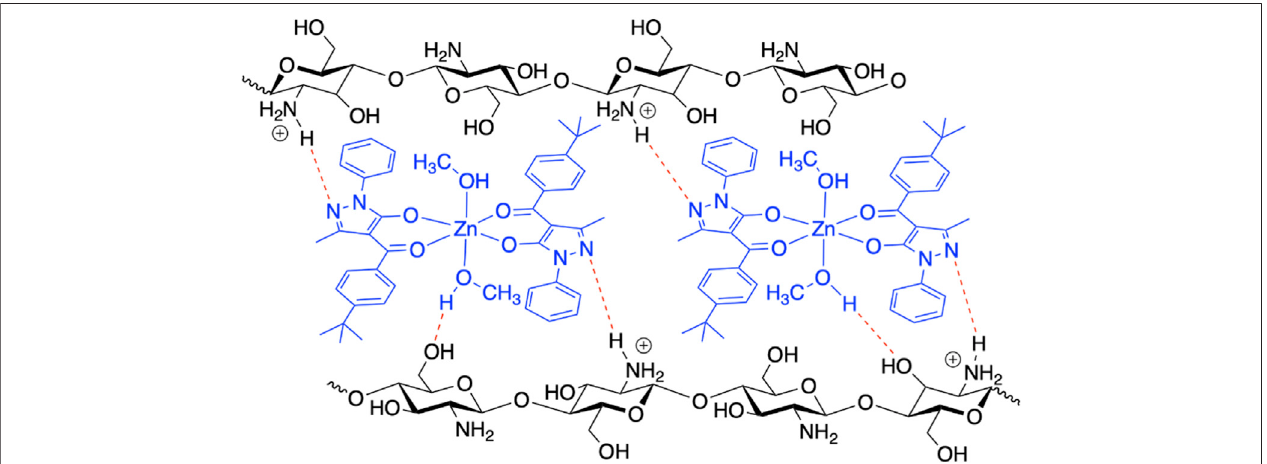
FIGURE 7| Proposed model scheme of the plausible intermolecular hydrogen bonds between [Zn(Q PhtBu ) 2 (MeOH) 2 ] and CSin the formation ofthe CS@Zn n fi lms.